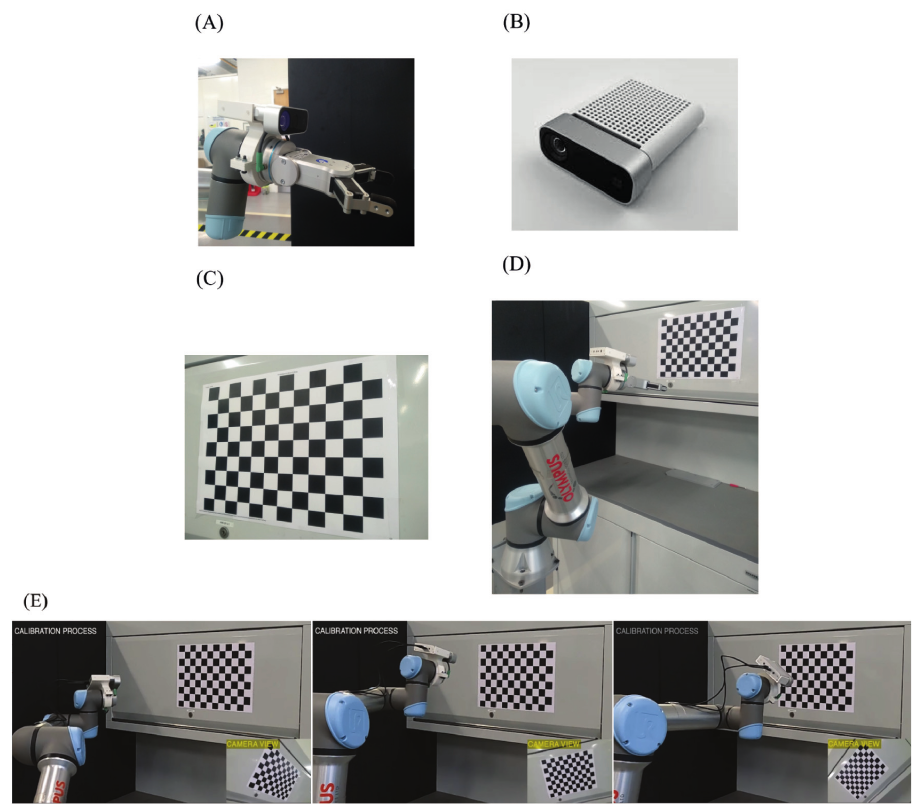
Fig 2. Hand-eye calibration setup. (A) Camera-End-Effector setup. (B) Camera. (C) Calibration pattern. (D) Experiment setup (E) Poses of robot and camera view representing camera pose during calibration